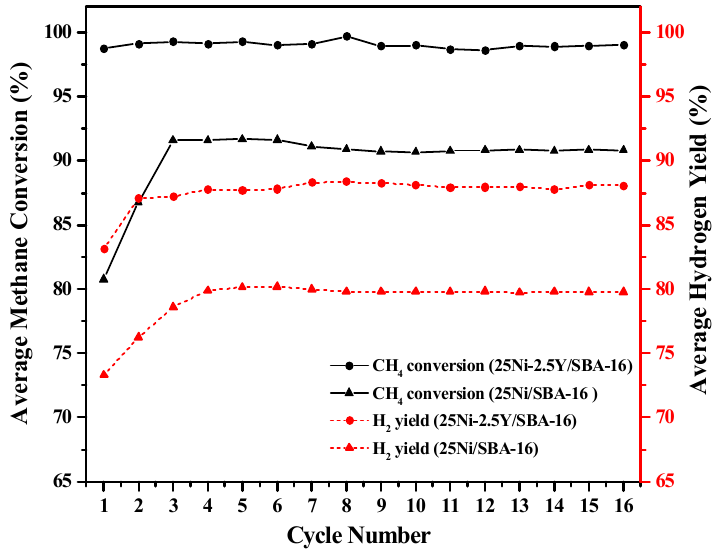
Figure 10. Life time of 25Ni/SBA ‐ 16 and 25Ni ‐ 2.5Y/SBA ‐ 16 oxygen carriers during 16 cycles at 650 °C.